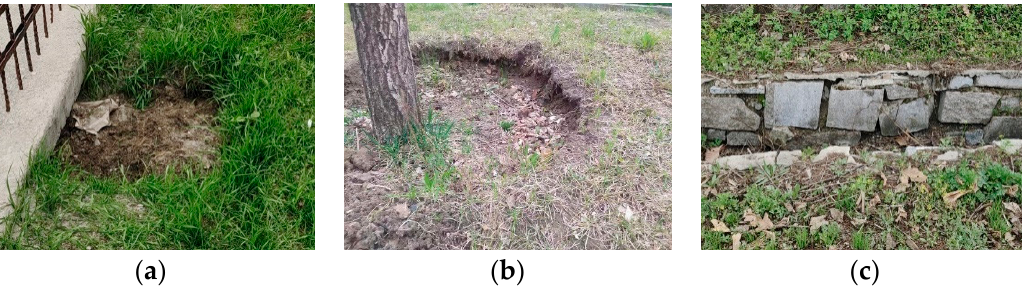
Figure 14. Unstructured experimental scenarios. ( a ) 1 m; ( b ) 1.5 m; ( c ) ∞ .